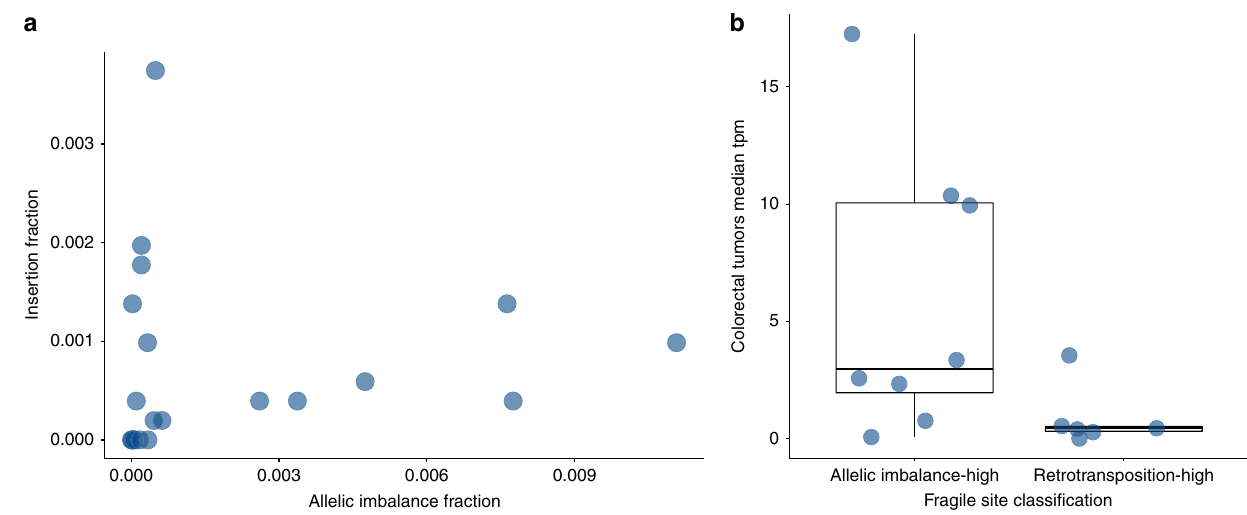
Fig. 5 Insertion and AI frequency in 21 fragile sites. a Insertion fraction over the fraction of allelic imbalance in 21 fragile sites. b Gene expression (median TPM values from 34 tumors) in fragile sites with high insertion fraction and fragile sites with high allelic imbalance fraction (Supplementary Data 3). Boxplot shows median, interquartile range (IQR), and whiskers extend to the most extreme data points which are no more than 1.5 times the